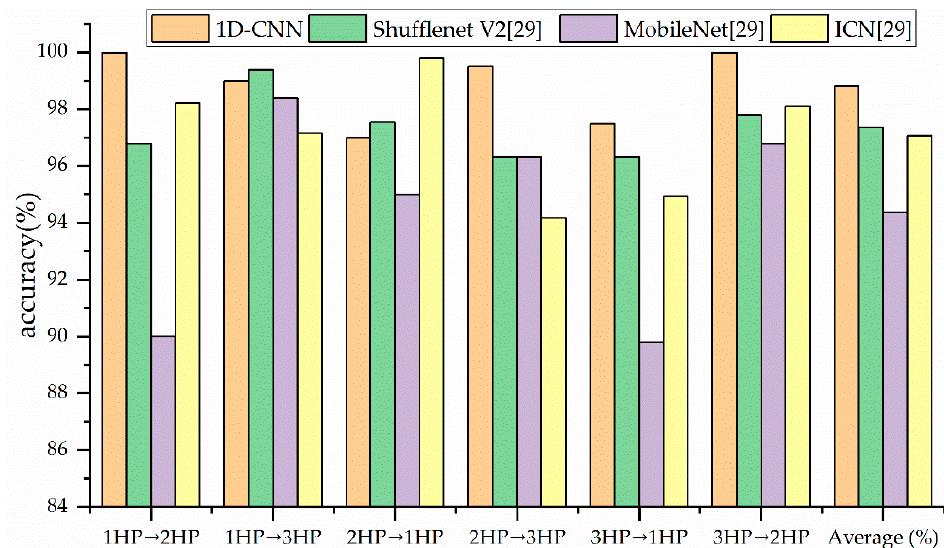
Figure 13. Accuracy of different models across loads.